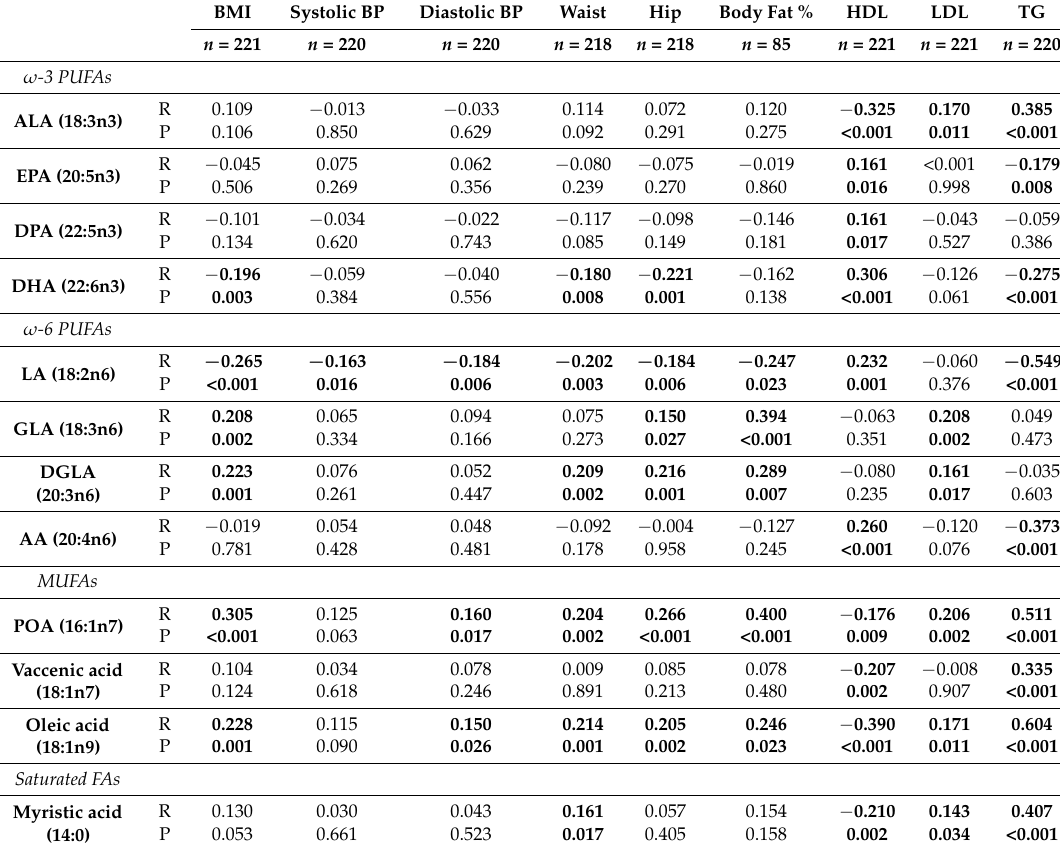
Table 4. Correlations of serum fatty acids with anthropometric measurements and blood lipids for all women. R = Pearson correlation coefficient. Significant correlations ( p < 0.05) are displayed in bold. BMI Systolic BP Diastolic BP Waist Hip Body Fat % HDL LDL